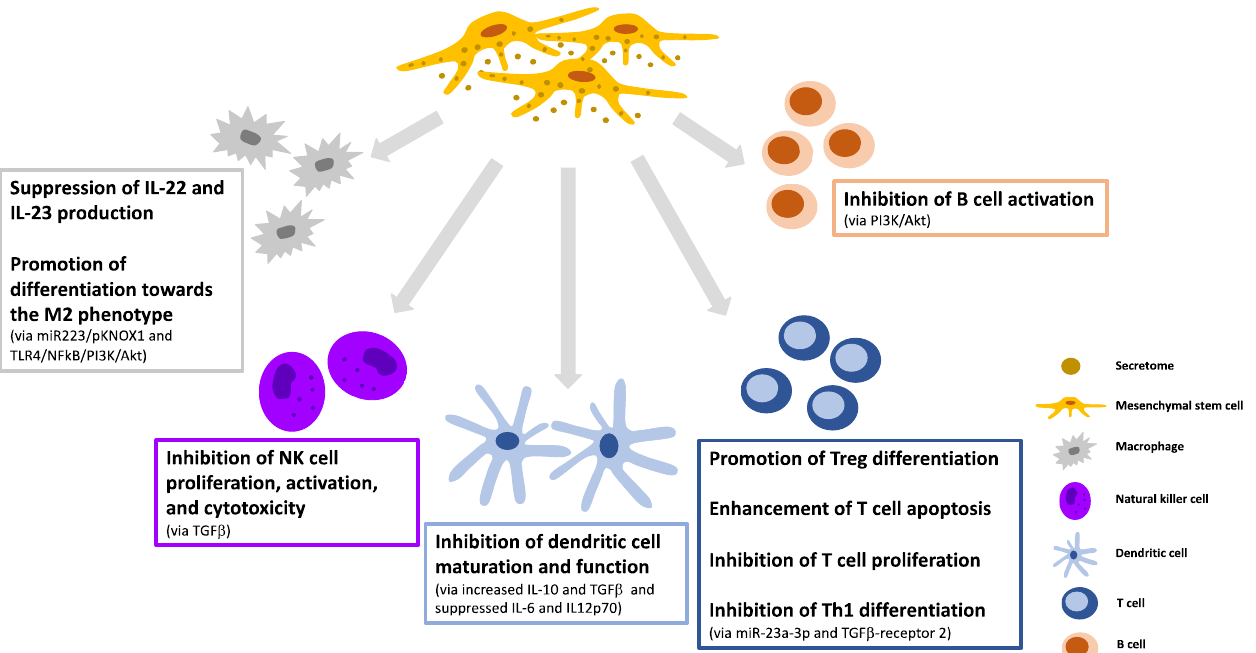
Figure 2. The beneficial immunomodulatory effects of the MSC-secretome. The diagram illustrates how MSC-secretome components contribute to the amelioration of inflammation. (IL: interleukin; pKNOX1: PBX/knotted 1 homeobox 1; TLR: Toll-like receptor; PI3K: phosphatidylinositol 3-kinase; NFkB: nuclear factor kB; TGF: transforming growth factor; Treg: regulatory T cell; Th1: type 1 helper T cell).